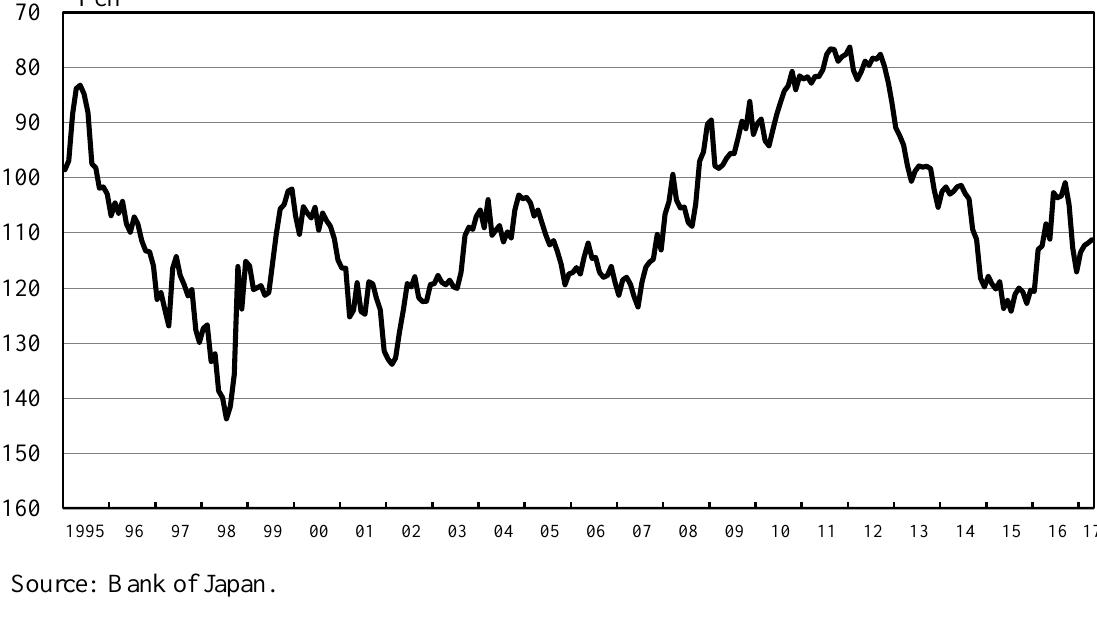
Yen Exchange Rate against the U.S.